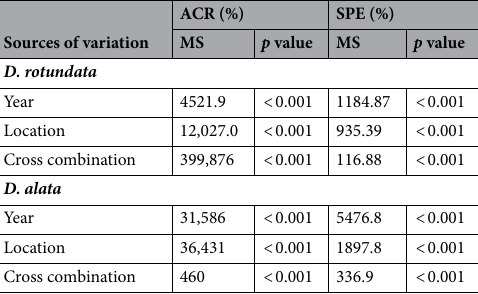
The highest interspecific ACR were recorded on D. rotundata when crossed with its wild relatives, D. bur- kiliana (29.2%) and D. hirtiflora (27.3%). Interspecific crosses involving D. alata had consistently lower ACR (Table 2). The highest interspecific SPE was recorded on D. rotundata × D. burkiliana (9.7%). Exogenous and genetic factors on yam cross-pollination success. Exogenous factors. Year, loca- tion, and pollinator effects significantly influenced the supervised cross-pollination success in yam (Tables 3, 4, 5, Table S5). The cross-pollination success indices such as the ACR and SPE were consistently higher at the Ibadan site than the Abuja on both D. rotundata and D. alata crossing blocks (Table 4). The highest ACR values, 27.7% on D. rotundata and 69.4% on D. alata crossing blocks were recorded in 2019. The lowest 10.7% on D. rotundata and 12.3% on D. alata crossing blocks were in 2017 and 2020, respectively (Table 5). The annual weather data did not fully explain the inter-annual variability in yam cross success. Instead, weekly variability in rainfall, temperature, relative humidity, sunshine, and the number of rainy days within the yam flowering window (July to November) significantly influenced the pollination outcomes in either the D.